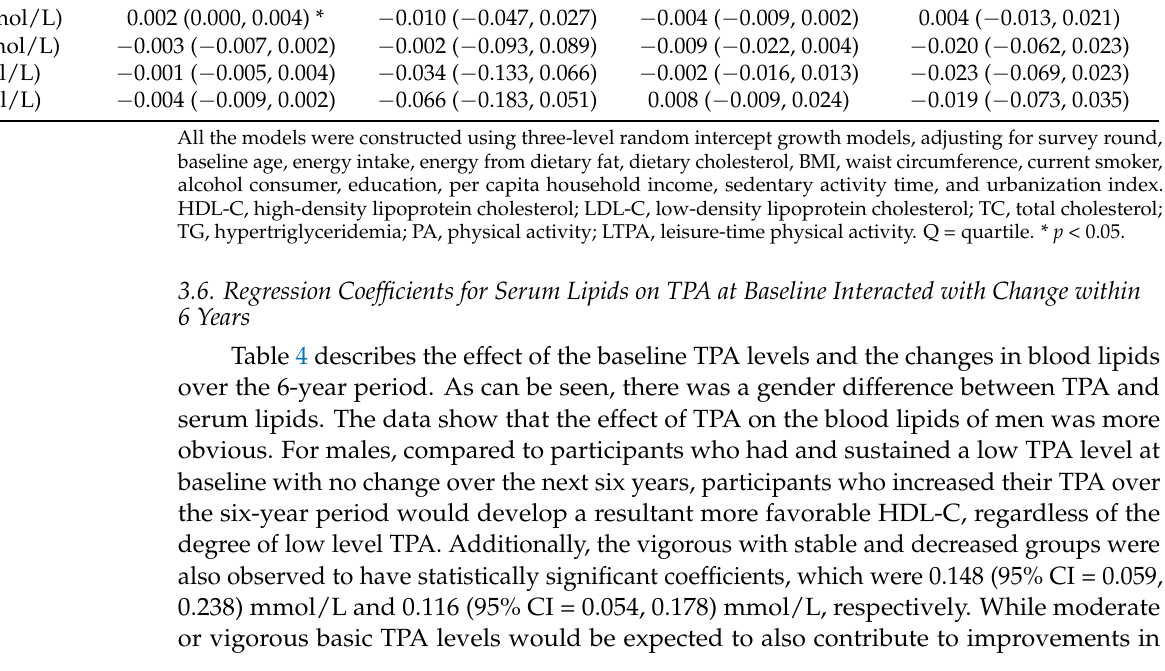
Table 3. Regression coefficients (95% CI) for serum lipids on the four subtypes of physical activity in Chinese adults from nine provinces, CHNS (2009–2015).